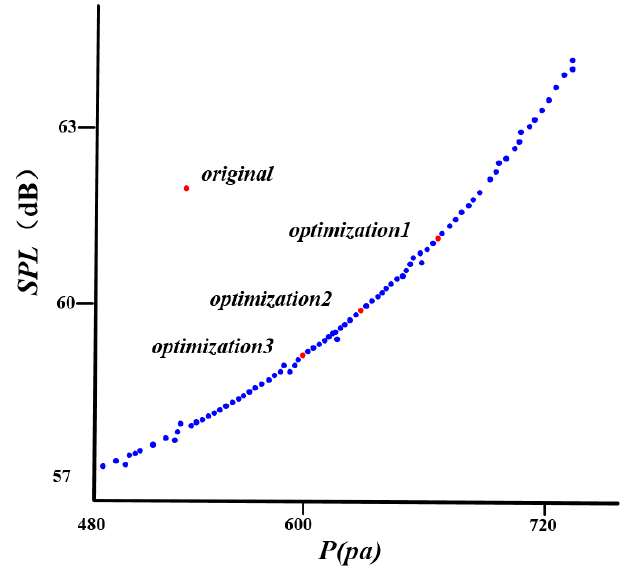
Figure 10. Pareto frontier for the optimization objective.